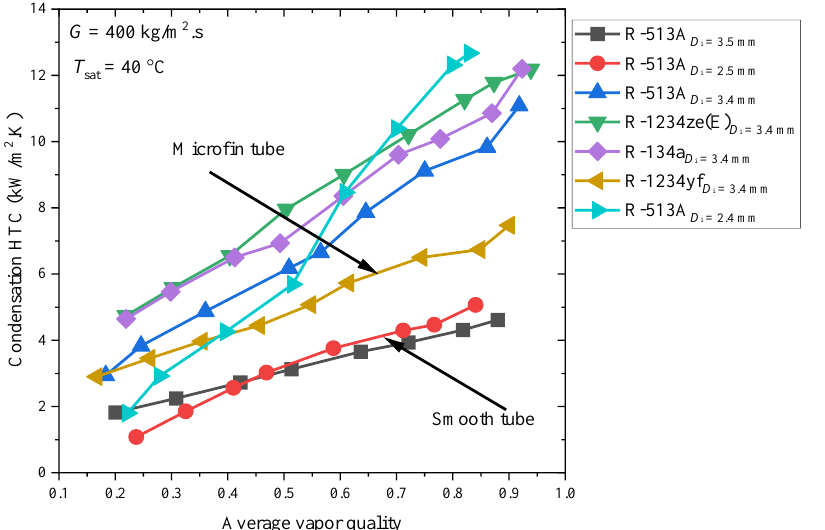
Figure 10. Condensation HTC of various refrigerants inside the smooth and microfin tube. Triangular backward solid connected line presents the Diani et al. [34], rectangular, triangular upward, and star solid connected line presents the Diani et al. [35], circular and triangular forward solid connected lines present the Diani and Rossetto [38] study.